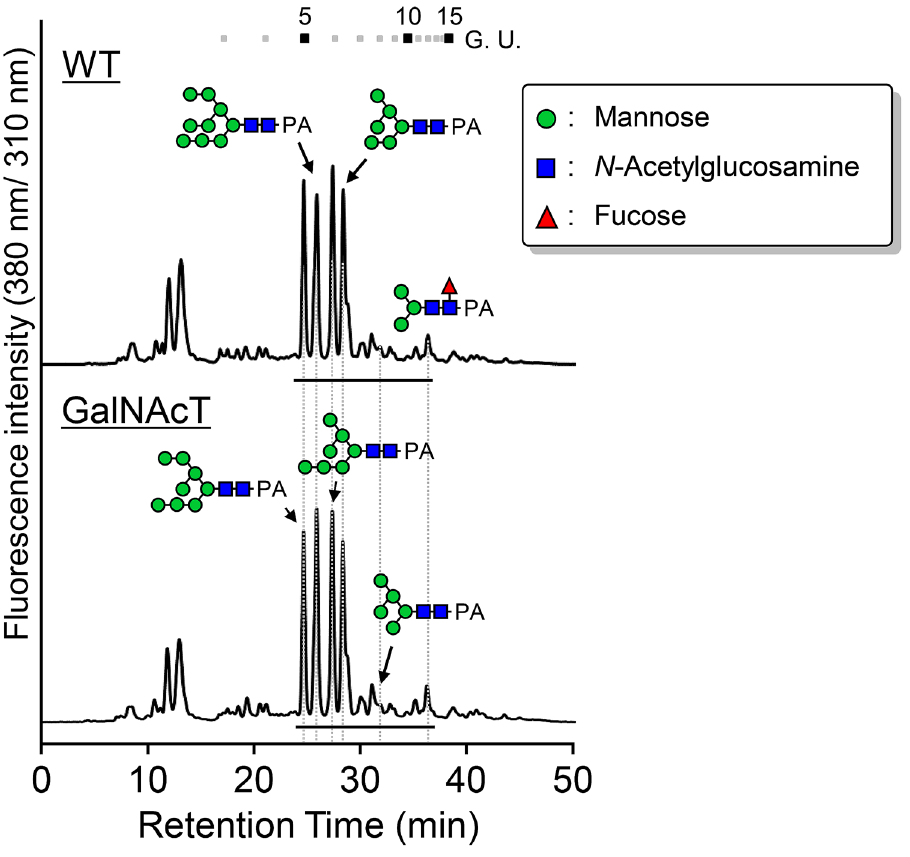
Figure 6. N -Glycan analysis of WT and BmGalNAcT-expressing Sf9 cells. Total soluble sugar chains prepared from glycoproteins and labeled with PA were analyzed by RP-HPLC. The major structures are shown in chromatographs. Underlining indicates the PA-sugar chain fraction applied to LC–MS/MS